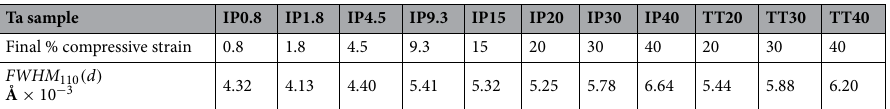
L -based virtual diffraction algorithm.